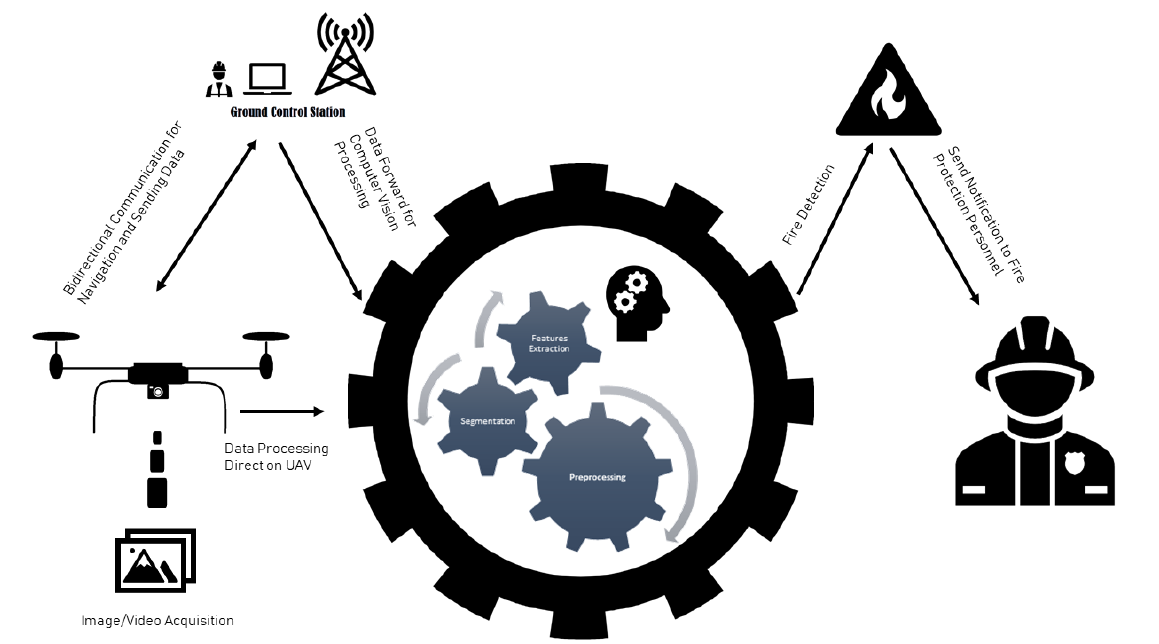
Figure 1. Fire Detection with UAV using Computer Vision